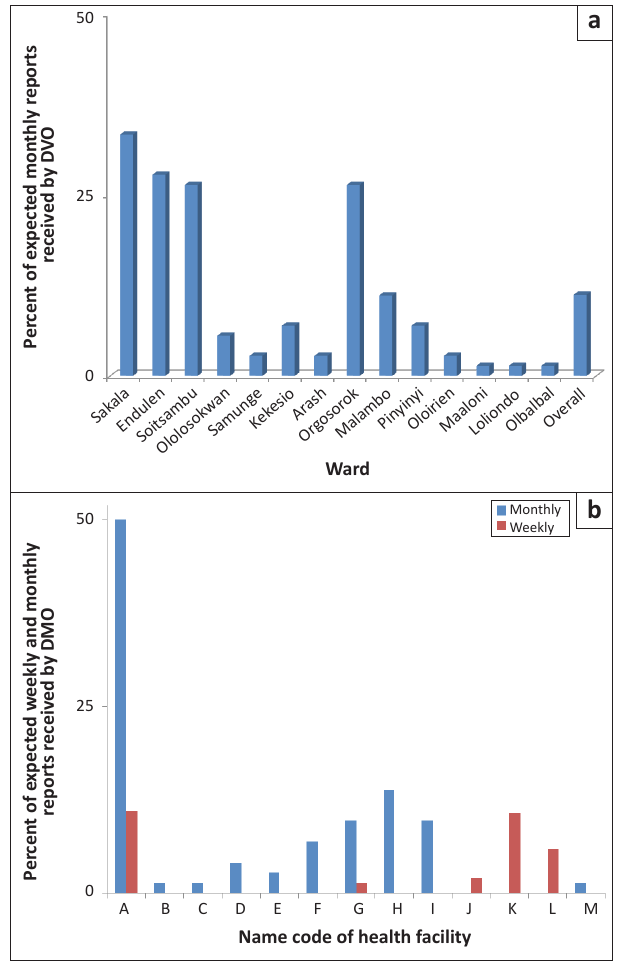
FIGURE 2: Completeness of disease reporting in the (a) animal and (b) human health